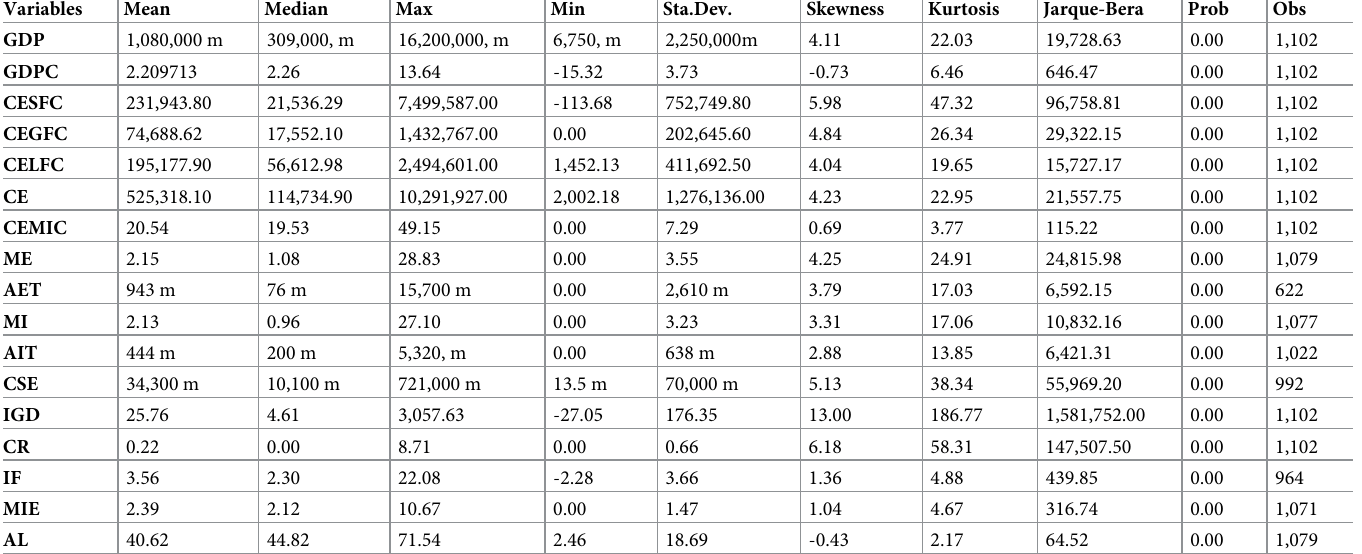
Table 5. Descriptive statistics (raw